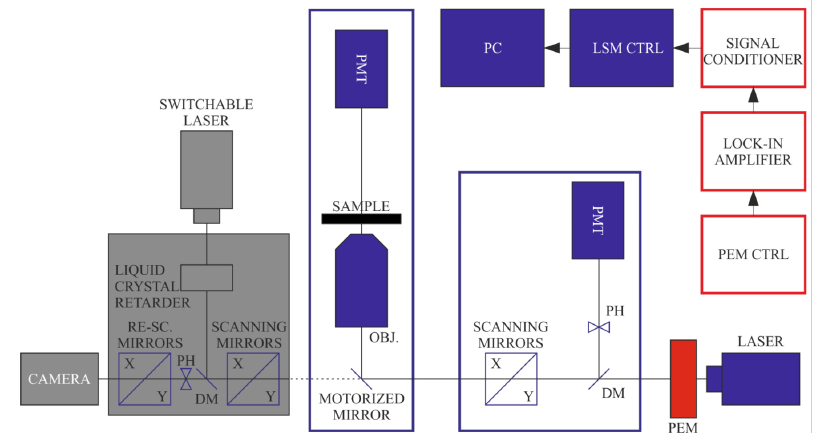
Figure 5. Configuration of DP-LSM for (non-confocal) LD and (confocal) FDLD imaging. Independent acquisitions of LD and FDLD were performed by using transmission and fluorescence detectors, respectively. (Components inactive in this configuration are displayed in grey).